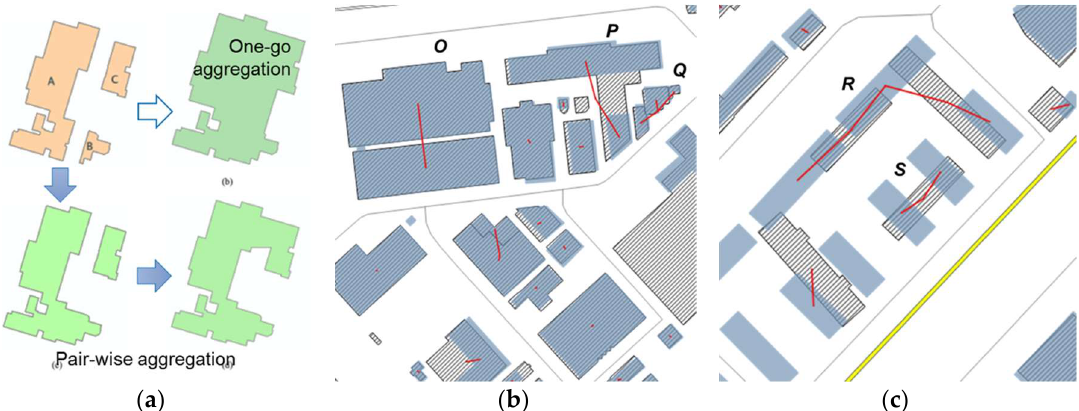
Figure 3. ( a ) Pair-wise vs. one-go aggregation illustrated; ( b ) the need for post-evaluation after the pair-wise aggregation. ( c ) For the m -to- n relations O and Q , the aggregation is helpful for the change comparison; for P , R , and S , too much empty space is enclosed by the aggregation and may lead to misleading results (e.g., the situation of P in particular).